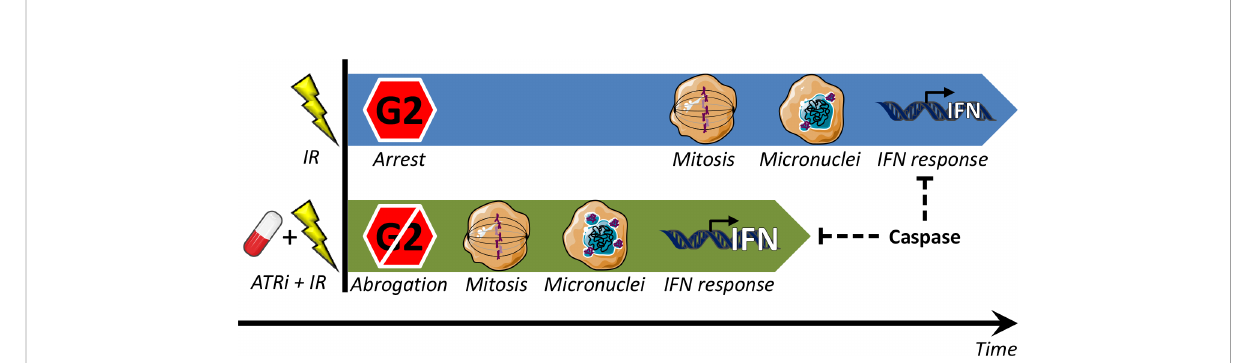
FIGURE 7 Model for regulation of type I IFN response by G2 checkpoint arrest. Treatment with IR alone (top) can induce a delayed IFN response, occurring after completion of the IR-induced G2 checkpoint arrest. When the G2 arrest is abrogated by ATRi (ATRi + IR; bottom), the IFN response comes earlier, and it is also stronger (because more micronuclei are formed when there is less time for DNA repair prior to mitosis). In both cases IFN is induced due to immune recognition of DNA from ruptured micronuclei, via the cGAS – STING – IFN pathway. This pathway can be suppressed by treatment-induced caspase